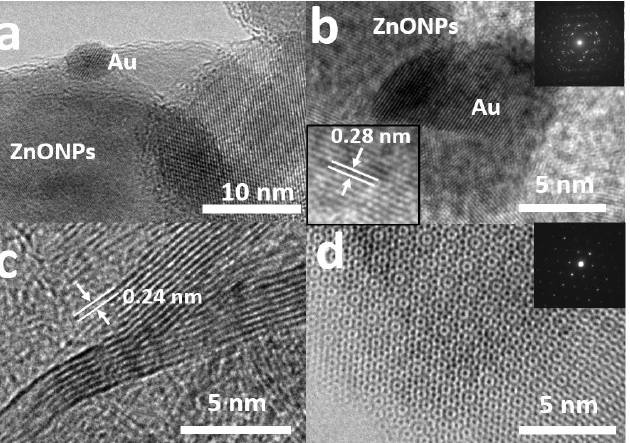
Figure 2. High-resolution transmission electron microscopy (HRTEM) micrographs of the precursors: Au@ZnONPs at a magnification of 100,000× ( a ); Au@ZnONPs with two insets showing the selected area electron diffraction, SAED, and a micrograph at higher magnification showing the